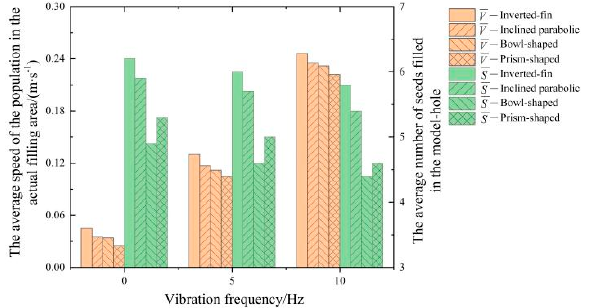
Figure 16. Effect of vibration frequency on the average speed of the population and the average number of grains filled in the actual seed filling area of wheat.